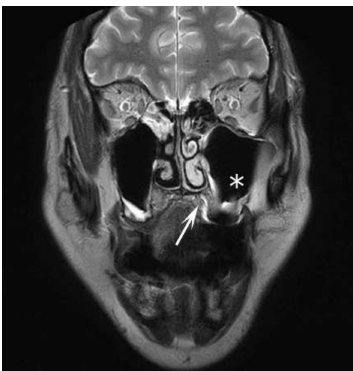
Figure 7. Follow-up MRI at 6-months: coronal T2 weighted image shows total regression. The * sign indicates the pneumatized left maxillary sinus. The white arrowhead marks the left side of the hard palate without tumor